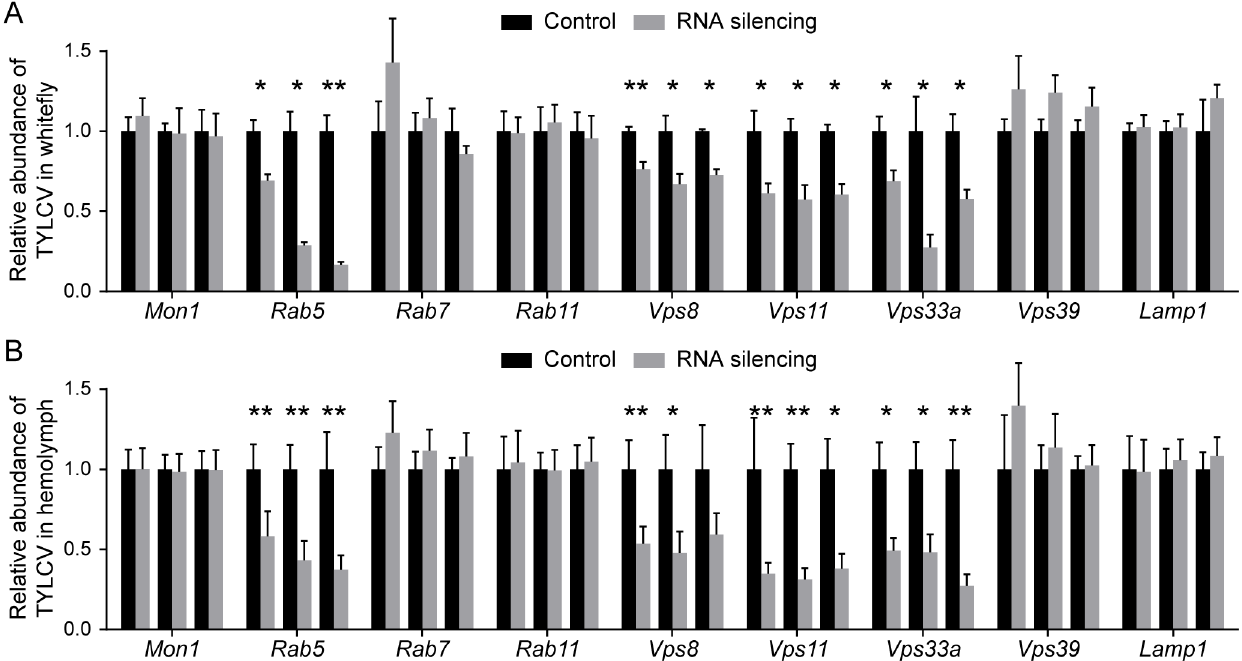
Fig 7. Involvement of endosomes in TYLCV trafficking. (A-B) TYLCV trafficking was influenced by knockdown of endosomal genes. Genes related to endosomal trafficking were silenced by dsRNA injection. The abundance of virus in the whitefly whole body (A) and hemolymph (B) were quantified by qRT-PCR after 48 h feeding on TYLCV-infected plants and compared with that in controls injected with dsRNA of GFP (for the whitefly whole body, n = 4–8; for hemolymph, n = 7–24). Data shown are mean ± SE. Statistically significant differences are indicated as: (cid:3) , P < 0.05; (cid:3)(cid:3) , P < 0.01.